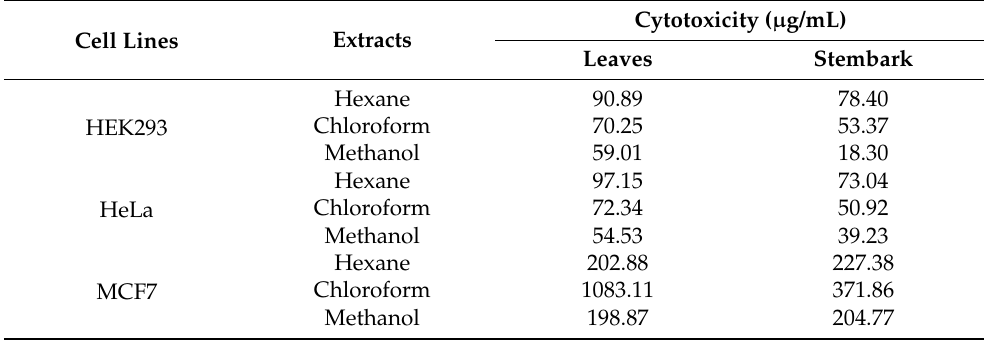
Table 5. IC50 values of the cytotoxic analysis of the leaf and stembark extract of C. erythrophyllum extracted in three solvents and tested on three cell